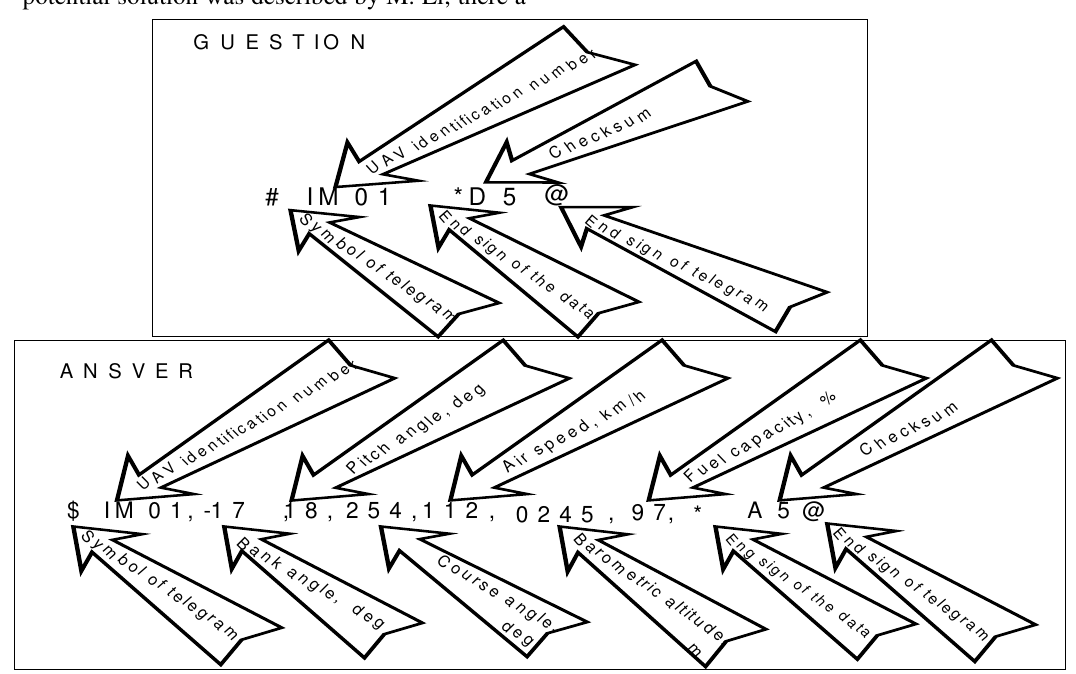
Fig 4. Structure of questioning message and answering message corresponding to the telemetry layout (Homziuk et al.